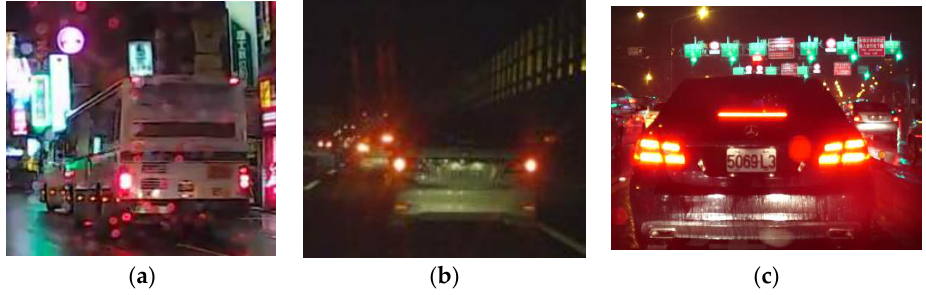
Figure 19. Vehicles not clearly defined ( a ) large cars with red signs ( b ) overlapping small cars ( c ) small car with signs.